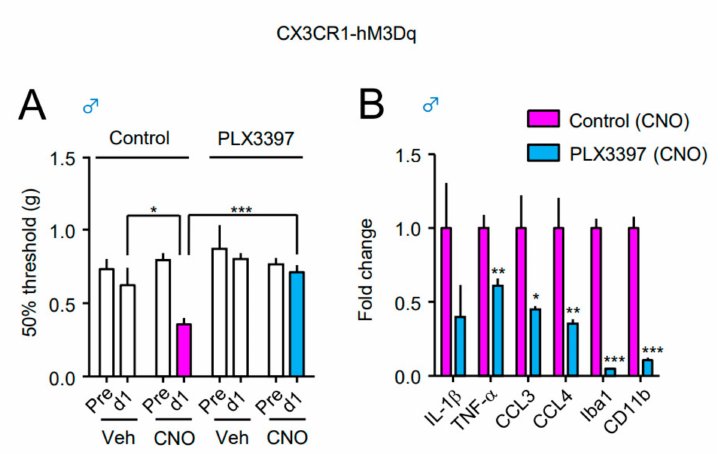
Figure 6. Contribution of microglia to CNO-induced mechanical allodynia and upregulation of inflammatory molecules in male CX3CR1-hM3Dq mice. Mice were fed with a control diet or pex- idartinib (PLX3397), a colony-stimulating factor 1 (CSF-1) receptor inhibitor, diet for 10 days, and CNO (2 nmol) or Veh was i.t. administered on the ninth day. ( A ) The 50% paw withdrawal threshold was assessed by the up–down method using the von Frey test before (day 9; pre) and one day after administration (day 10; d1). ( B ) The mRNA expression of inflammatory mediators (IL-1 β , TNF- α , CCL3, and CCL4) and microglial markers (Iba1, CD11b) in the spinal cord was analyzed by RT-qPCR one day after CNO administration. Data are presented as mean ± SEM. ( A ) n = 5 − 10. ( B ) n = 9 − 10. ***, p < 0.001. **, p < 0.01; *, p < 0.05. vs. ( B ) control